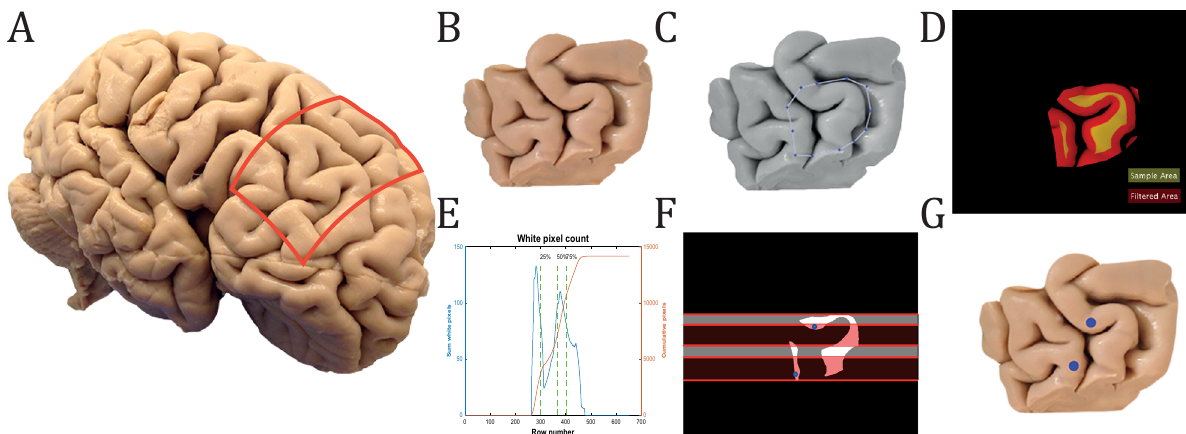
Fig. 1 Sampling of biopsies at BA46. A Formalin- fi xed tissue from three human brains was selected from the brain collection at Aarhus University Hospital. The red box marks the excised area of the tissue. B Fixed coronal block of tissue containing BA46. C Manual delineation of BA46 performed by MATLAB. D Infused image between global threshold image and sample area. The fi ltered surface of a coronal block of tissue containing BA46 was marked with a red and yellow map that shows the available sample area. E Summation of all white pixels for each row of the binary picture of the sample area. The 1st, 2nd, and 3rd quarter of pixels were marked with a green dashed line. F The two biopsies can only be sampled in either the 1st and 3rd quarter(white area) or the 2nd and 4th quarter (red area). In this case, random points in the 2nd and 4th quarters, marked with blue dots, were chosen by the algorithm. G The two chosen biopsies are marked with blue dots on the original block of tissue from ( B ).